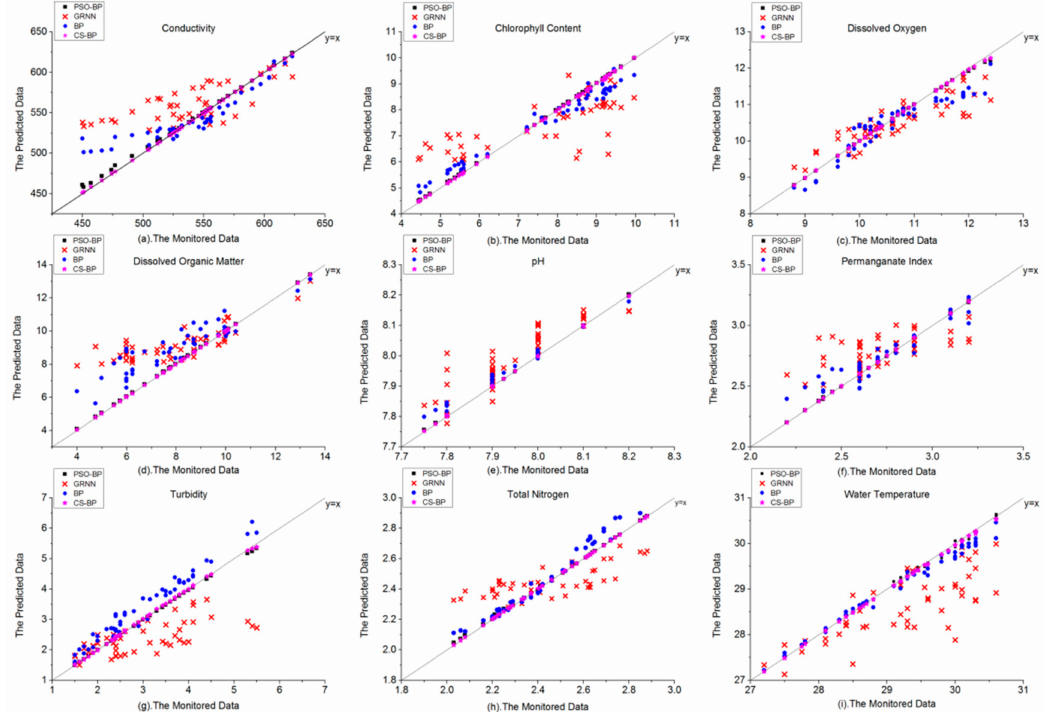
Figure 10. Comparison results of predicted and monitored data of water quality indicators of four models of part B in Scenario